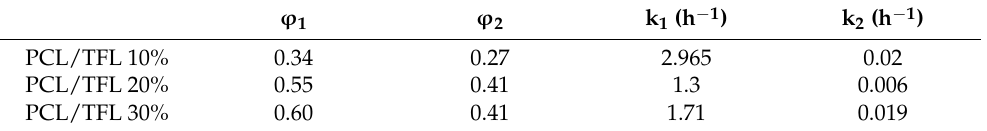
Table 9. Estimated parameter derived by fitting of the experimental release data.